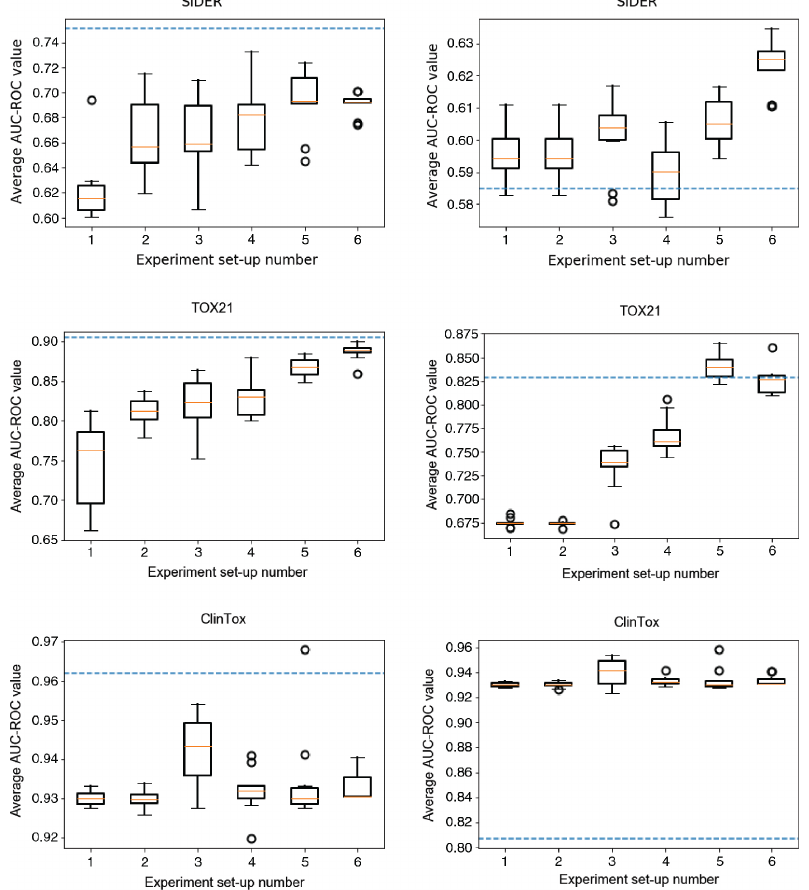
Figure 2: The distribution of the achieved AUC-ROC values averaged over all target variables for each experimental set- up. The blue dashed line represents the result achieved by the GCNN presented by Wu et al. [21]. The left plot is the achieved results on the training data and the right plot is the achieved results on the test